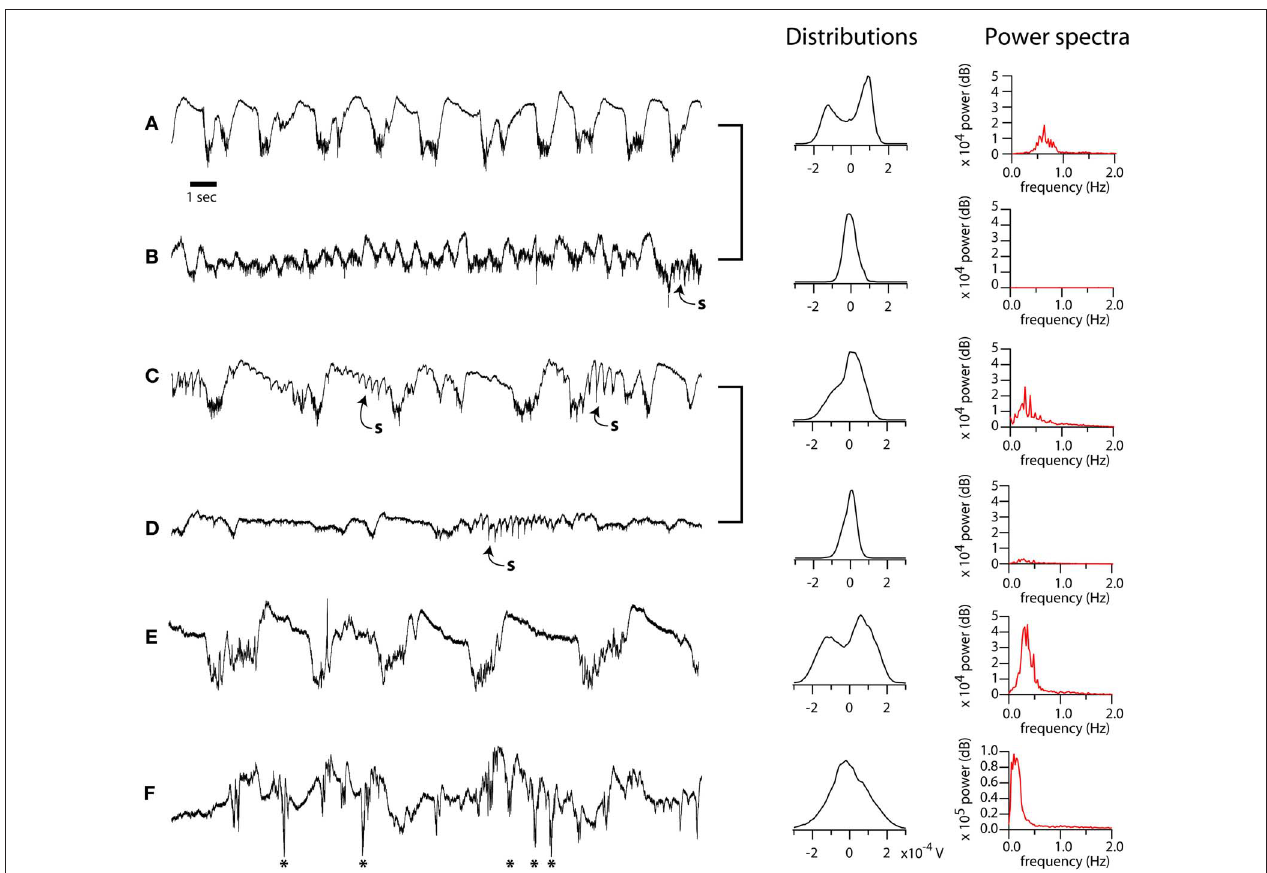
FIGURE 1 | Diversity of spontaneous LFP patterns in mouse barrel cortex under ketamine-xylazine anesthesia. (A–F) , left column: Selected 20s epochs of LFP displaying typical variation in electrographic features. Recordings from same preparation (A–B, C–D) grouped with brackets. Sleep spindles in B, C, D , indicated by “s.” Paroxystic events in F indicated by